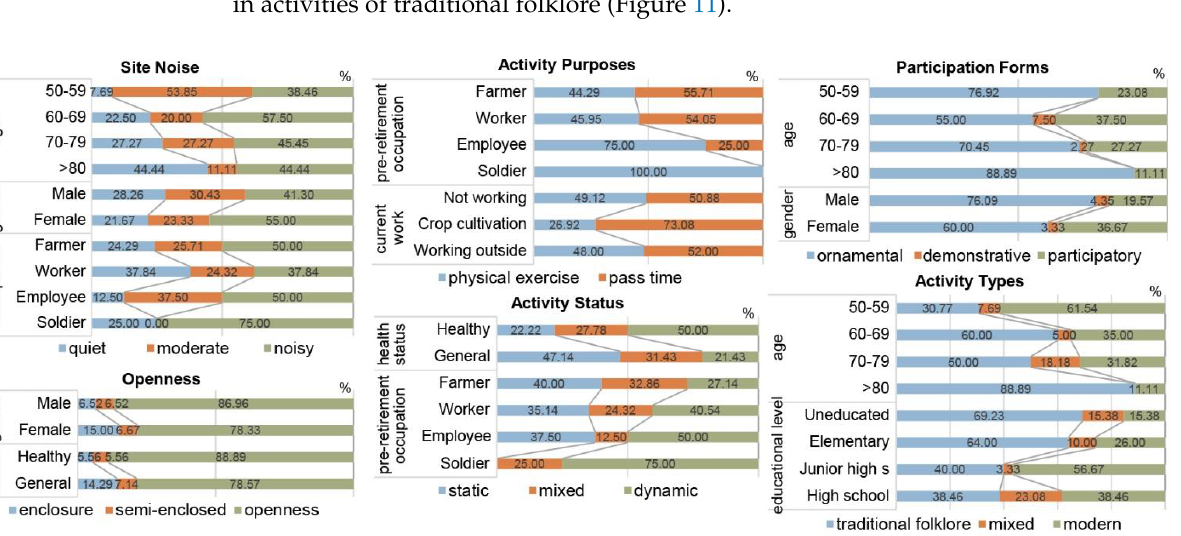
Figure 11. Relationship between personal attributes and spatial preferences — part 2.